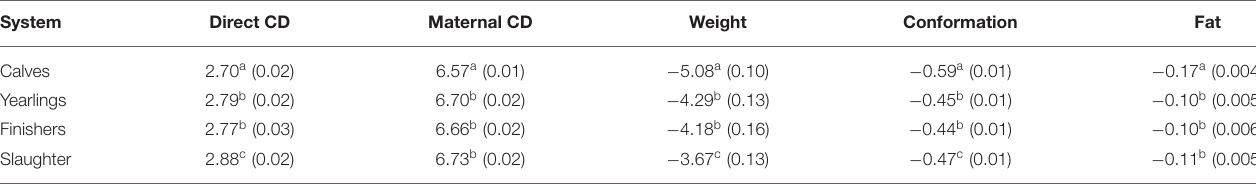
TABLE 5 | Least squares means (SE in parentheses) predict transmitting ability for direct and maternal calving difficulty (CDdiff; percent difficult calvings), carcass weight (weight; kg), conformation [scale 1 (poor) to 15 (excellent)], and fat score [scale 1 (lean) to 15 (fat)] of the dams of the progeny depending on whether the surplus progeny are marketed as calves, yearlings, finishers, or slaughtered immediately on exiting the